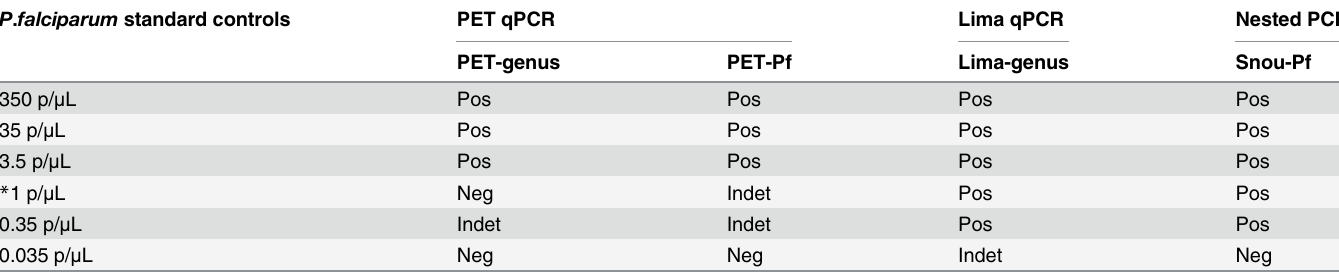
Table 1. Limits of detection of molecular assays using standard controls obtained from in vitro culture. P . falciparum standard